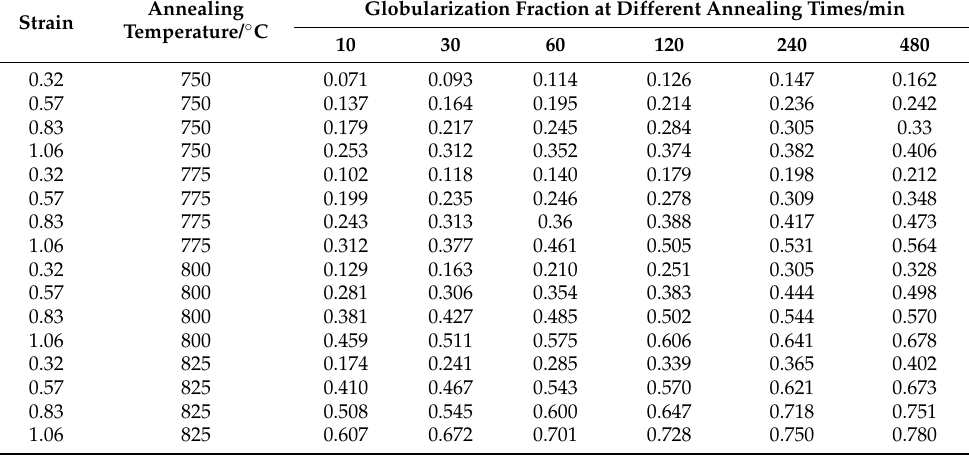
Table A1. Experimental data of Ti-55511 alloy for